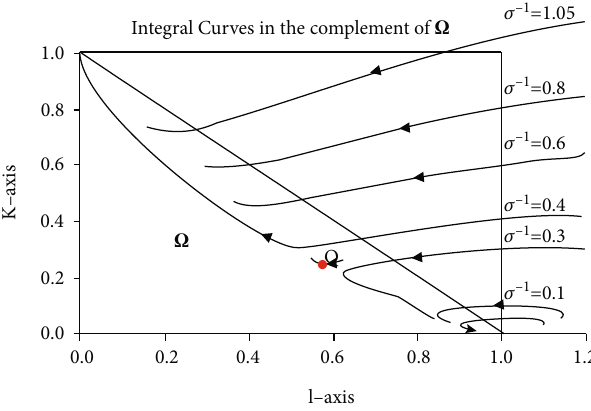
Figure 3: Integral curves of (10) in the complement of Ω impinging into di ff erent equilibrium